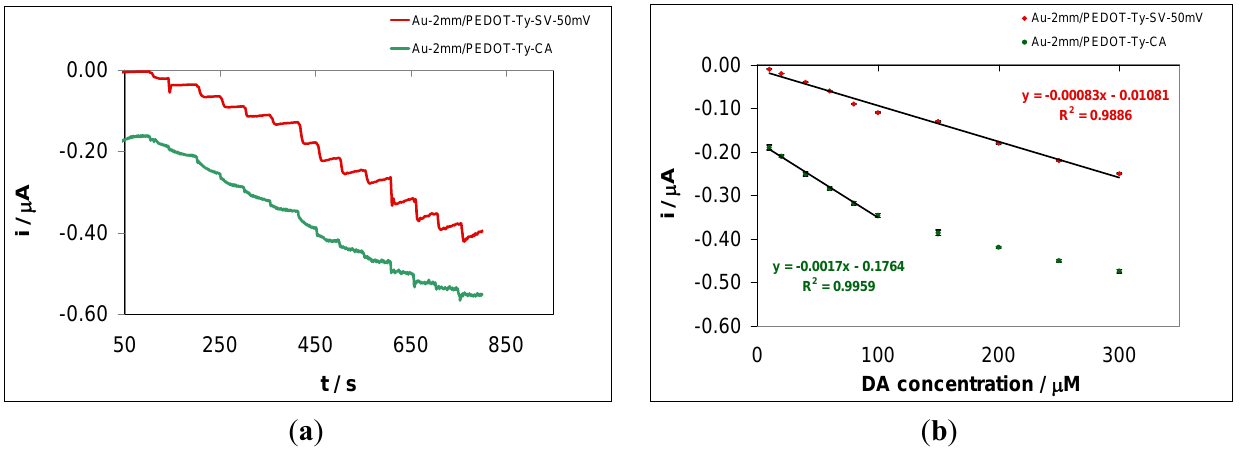
Table 1. Analytical performances of tyrosinase based biosensors for dopamine detection. Linear